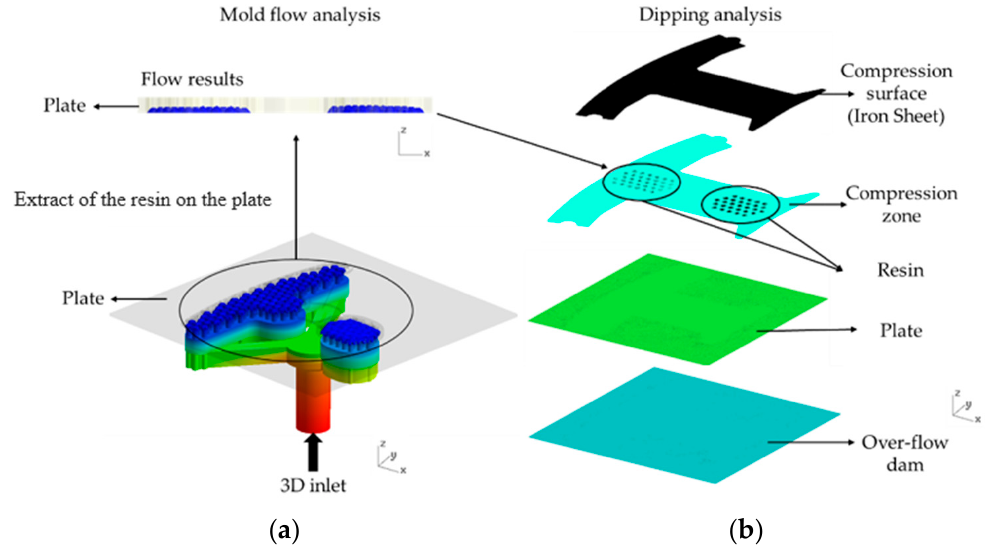
Figure 7. The simulation flow chart. ( a ) The simulation flow chart of the mold flow analysis and ( b ) the simulation flow chart of the dipping analysis.